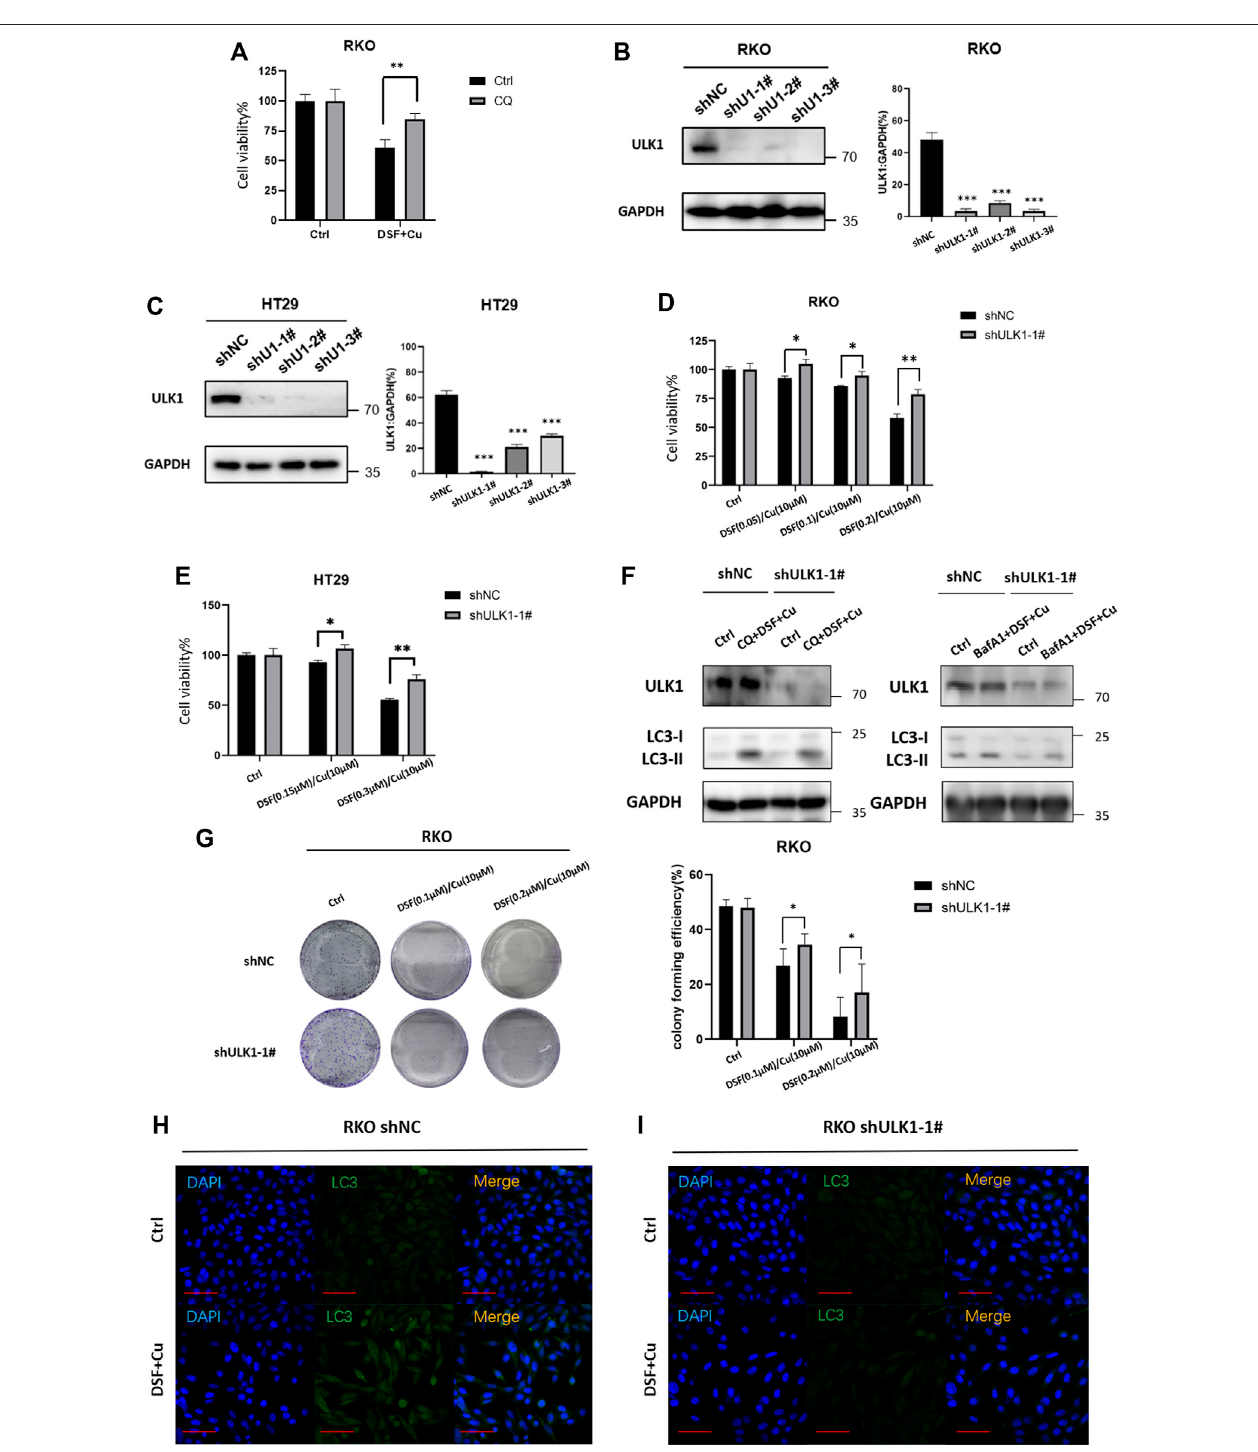
FIGURE5| DSF/CuinducedautophagiccelldeathbyupregulatingULK1. (A) CQcanpartiallyreversethecellviabilitycausedbytheDSF/CutreatmentinRKO( p < .01). (B,C) Low expression of ULK1 in CRC cell lines is established in RKO and Ht2, and the ef fi ciency was veri fi ed by Western blot and qRT-PCR. (D,E) CCK8 assay showed that cell viability could be partially reversed in the low ULK1 expression group after incubation with DSF/Cu (DSF 0 – 0.2 μ M/Cu 10 μ M in RKO cells, DSF 0 – 0.3 μ M/Cu10 μ MinHT29cells)for48h( p < .01). (F) WesternblotshowedthatDSF/CucombinedwithCQorBafa1couldnotenhancetheaccumulationofLC3- II inshULK1-RKO. (G) Colonyformationassay showed thatcell viability could bepartiallyreversedin thelowULK1 expression group after incubation withDSF/Cu (0.25/ 10 μ M)for48h( p < .01). (H,I) TheexpressionofLC3detectedbyimmuno fl uorescenceintheshULK1-RKOgroupwaslowerthantheshNC-RKOgroupafterincubation with DSF/Cu (0.25/10 μ M) for 48 h ( p < .01).